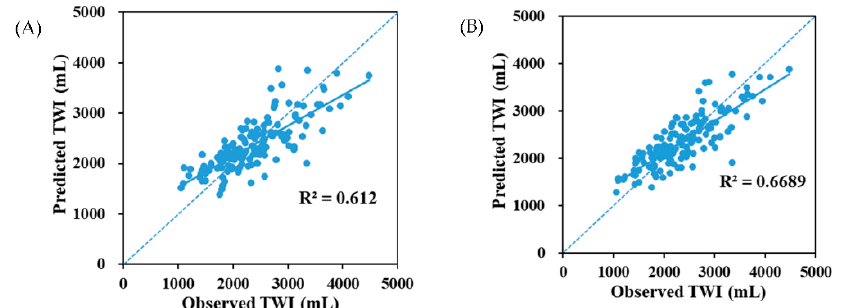
Table 3. Variable importance in the projection (VIP) coefficients for the 24 h urine hydration bi- omarkers in the partial least squares (PLS) model (TWI) .